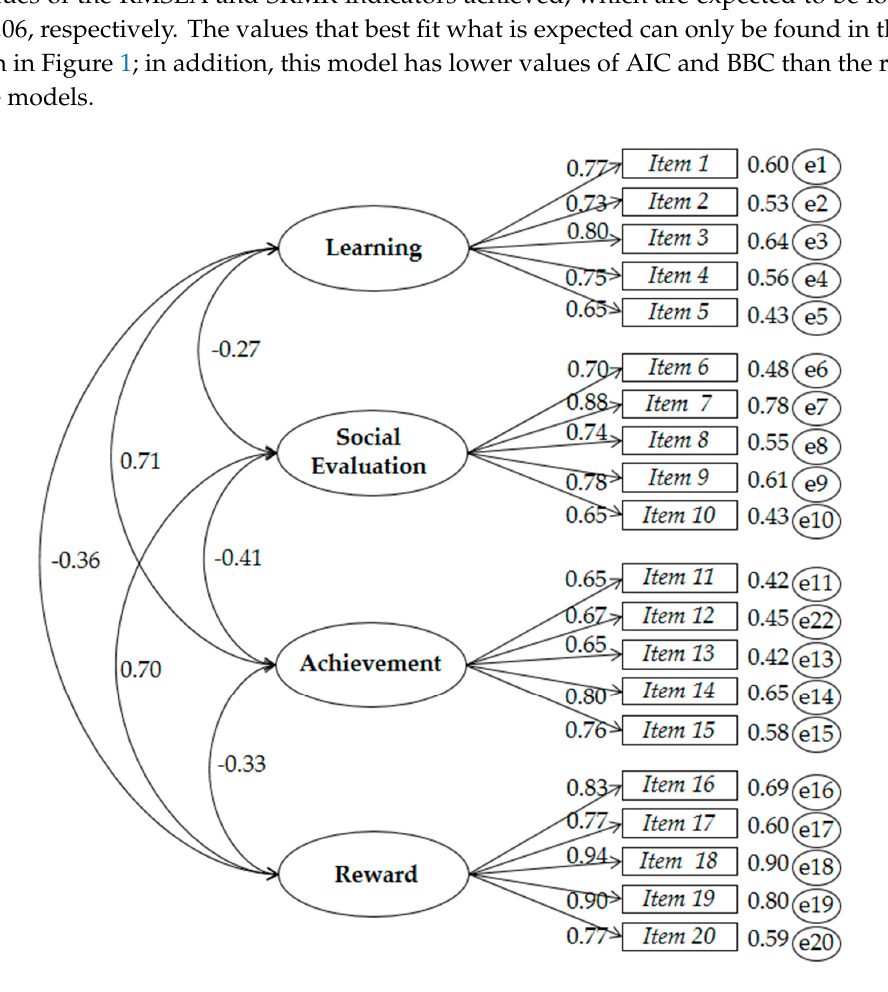
Table 2. Goodness of fit indices of the proposed models